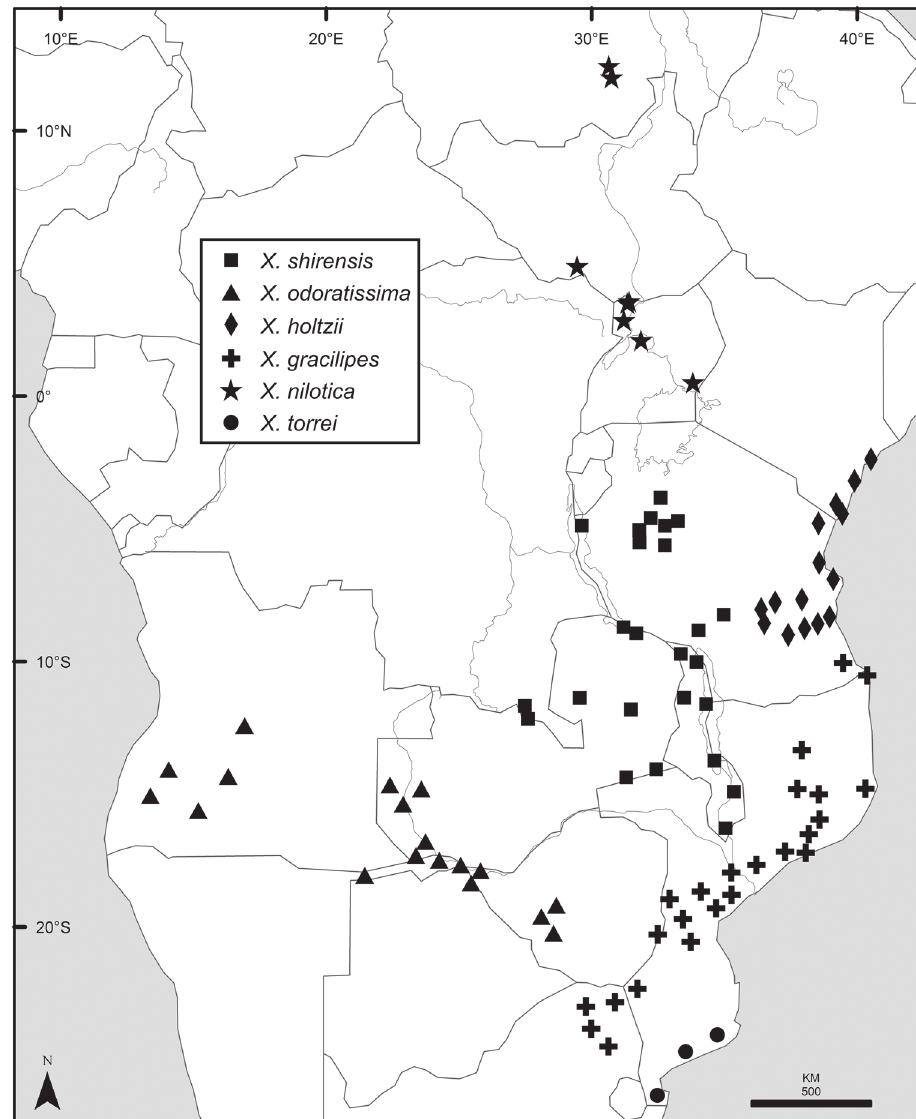
Figure 26. Distributions of Xylopia shirensis , X. odoratissima , X. holtzii , X. gracilipes , X. nilotica , and X. torrei . Bolder lines represent country borders, fainter lines lakes and major